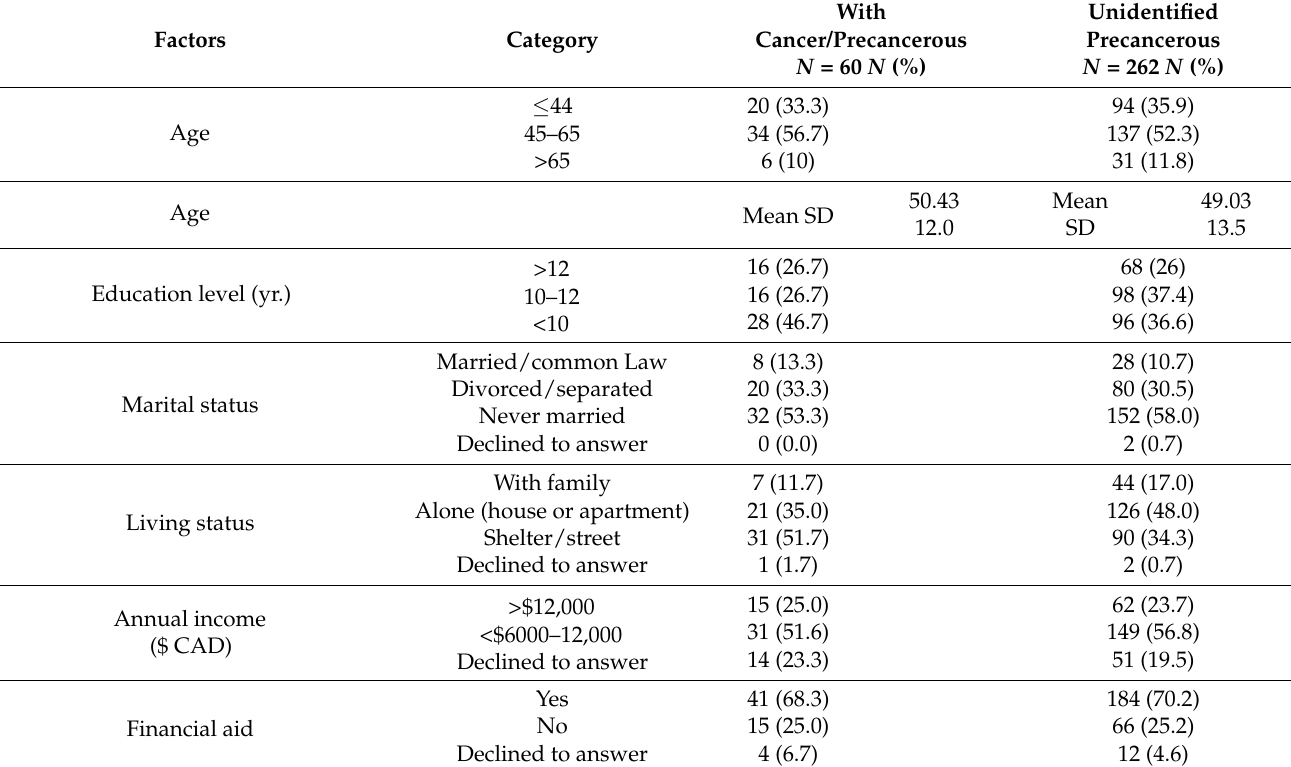
Table 4. Oral cancerous/precancerous lesions group vs. cancer-free